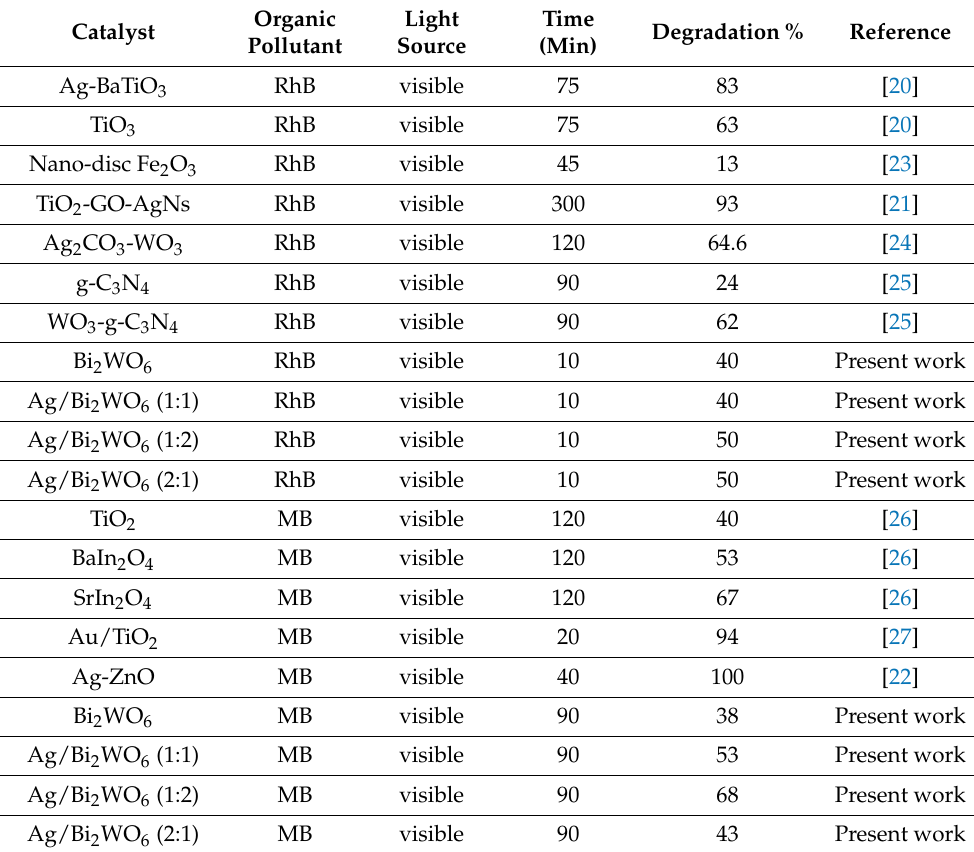
Table 1. Summary of photocatalytic degradation of RhB and MB by different